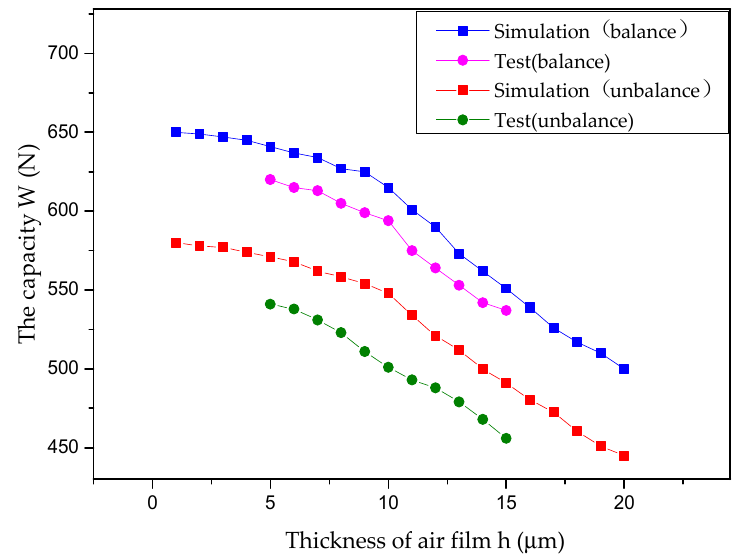
Figure 17. The variations of bearing capacities with the thickness of air films by the simulations and experiments.